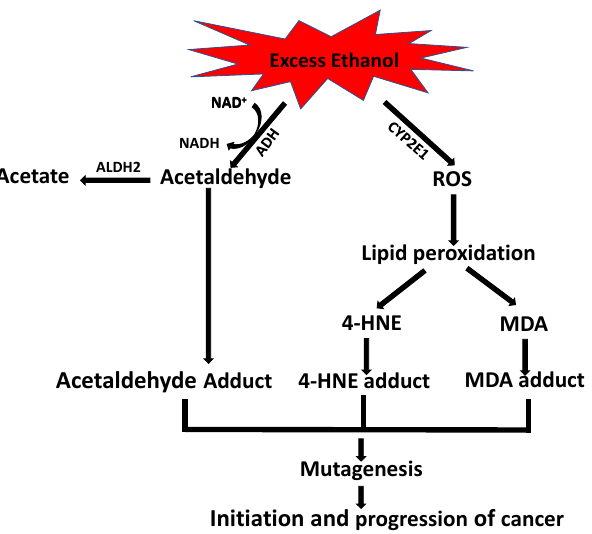
Figure 3. Schematic representation of 4-HNE-induced carcinogenesis due to chronic alcoholism. Chronic/high levels of alcohol consumption cause significant changes in alcohol metabolism by additional activation of CYP2E1, which metabolizes alcohol and produces acetaldehyde as well as ROS. ROS increase lipid peroxidation, leading to the production of the toxic end products 4-HNE and MDA. Increased levels of acetaldehyde, 4-HNE, and MDA react with DNA bases, leading to the production of the carcinogenic adduct, which, subsequently, causes mutation of certain genes, resulting in the initiation and progression of cancer.